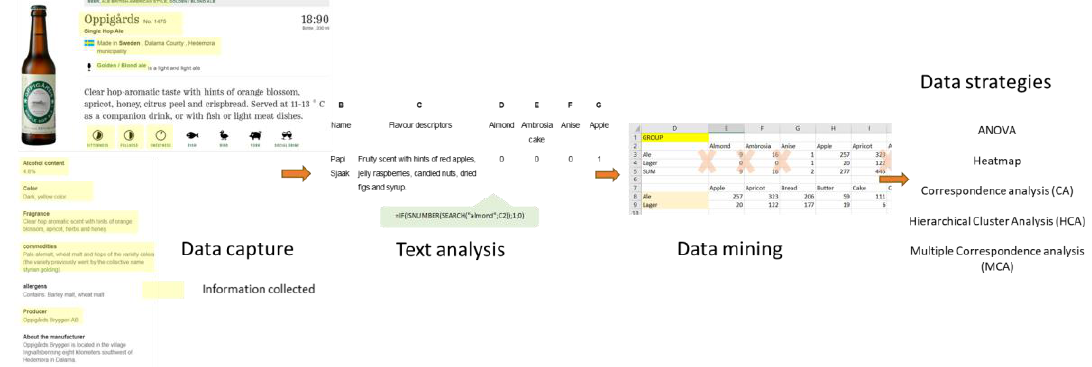
Figure 1. Flowchart illustrating the workflow process from data capturing to multivariate analysis.